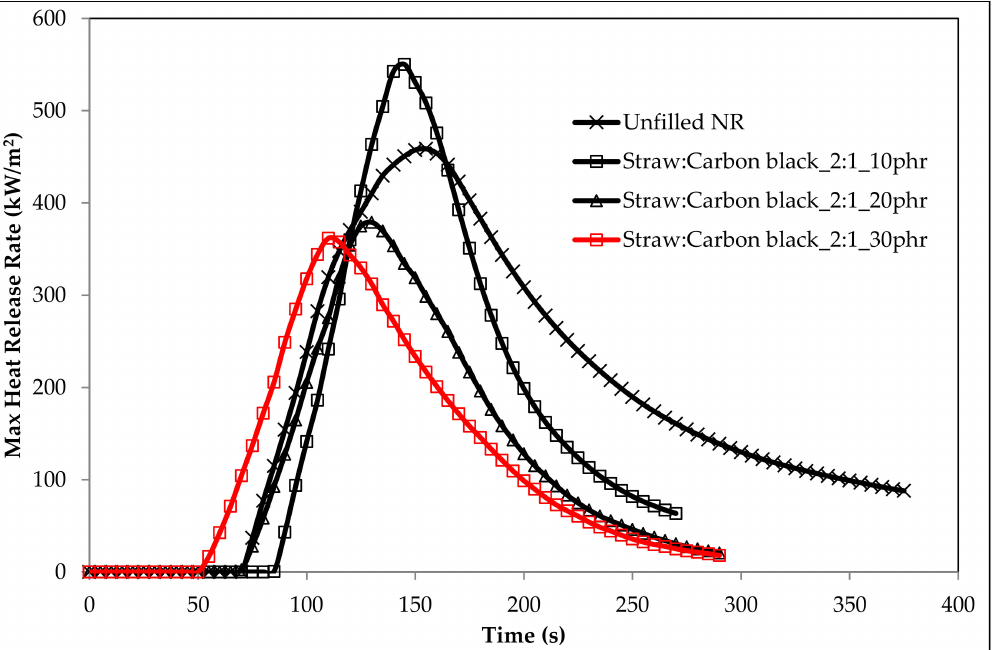
Figure 19. HRR MAX curves of biocomposites containing Straw:Carbon black_2:1